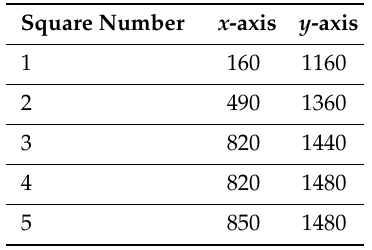
Table 2. Coordinate information of symbol “ ㄋ